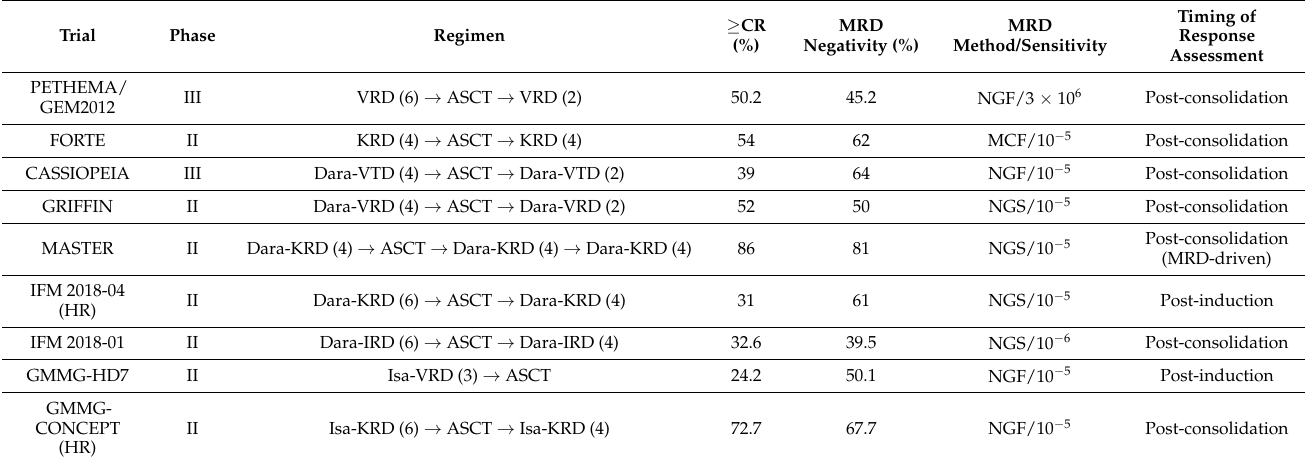
Table 2. MRD rates in three-drug and four-drug clinical